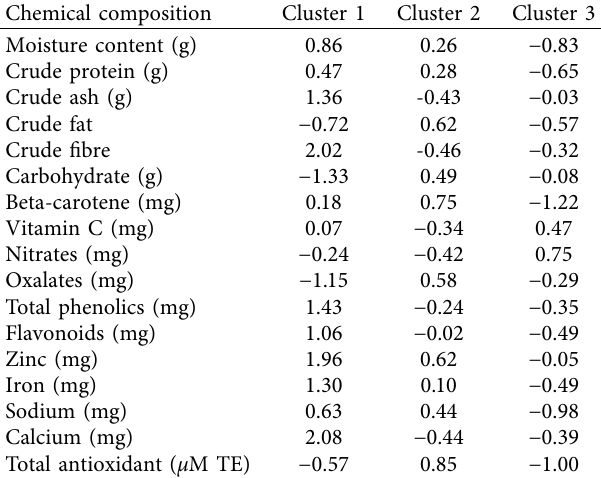
Table 5: Normalized means of clustered nutrient and antinutrient composition of cowpea leaves harvested at diferent maturity stages.